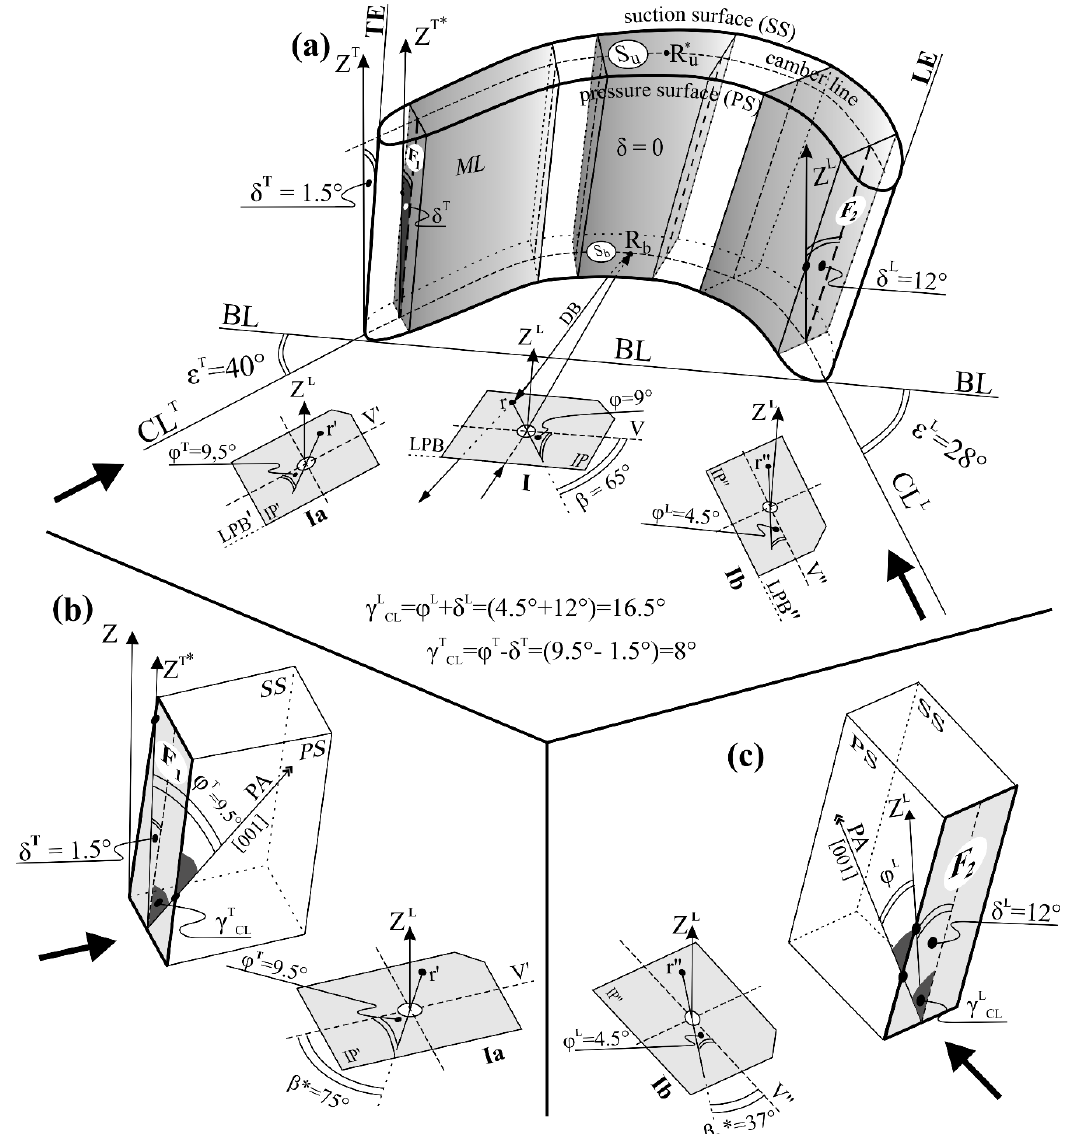
Figure 7. ( a ) Illustration of sample M with marked R b and R u points at which the Laue diffraction patterns were recorded, the image plate (IP) location and position r of the reflection from (001)-type diffraction planes in the initial Laue pattern I on the IP, as well as a hypothetical Laue pattern obtained by IP rotation relative to Z L with marked new positions r' and r'' of the same reflection on the rotated Laue patterns Ia and Ib; ( b ), ( c ) diagrams for calculating the angles between the [001] direction parallel to the primary dendrite arms and surfaces of the mould. F 1 and F 2 surfaces of M sample section were perpendicular to the CL T and CL L fragments of CL and parallel to the Z axis. Large black arrows indicate the view direction. TE: trailing edge; LE; leading edge.